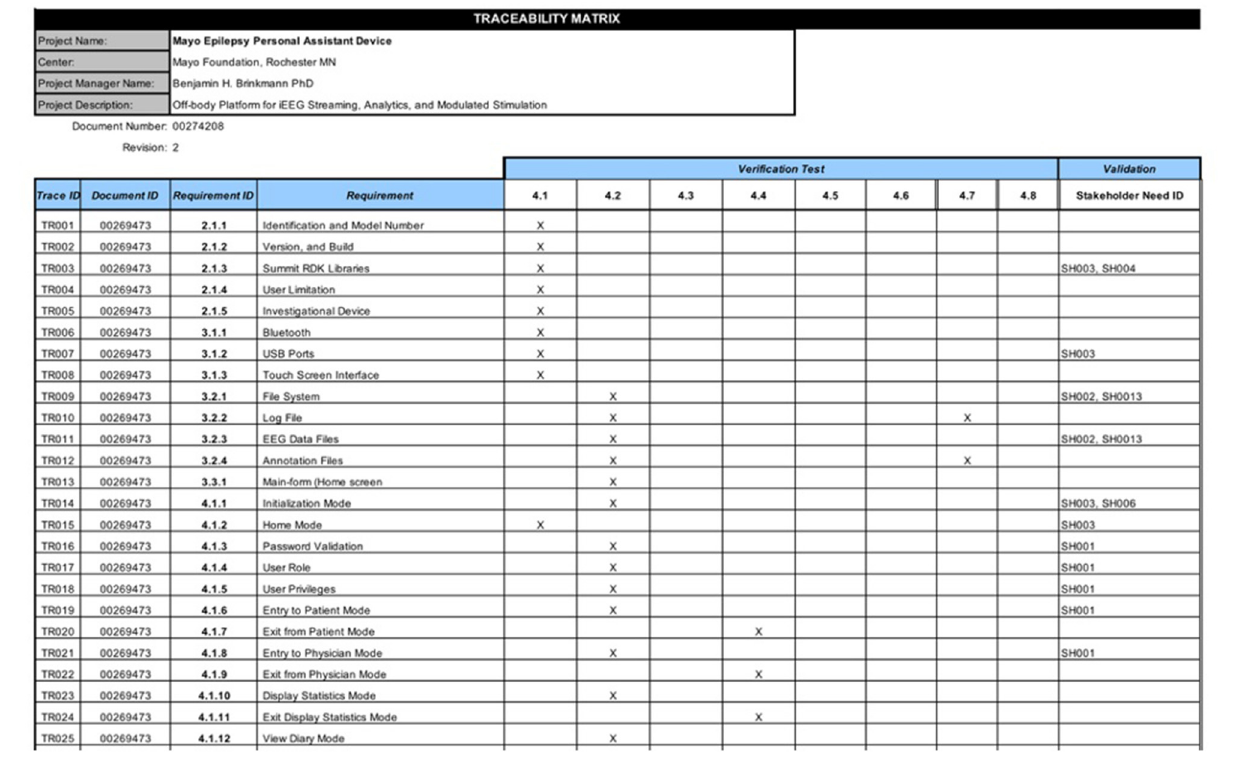
FIGURE 4 | An excerpt from the EPAD Requirements Traceability